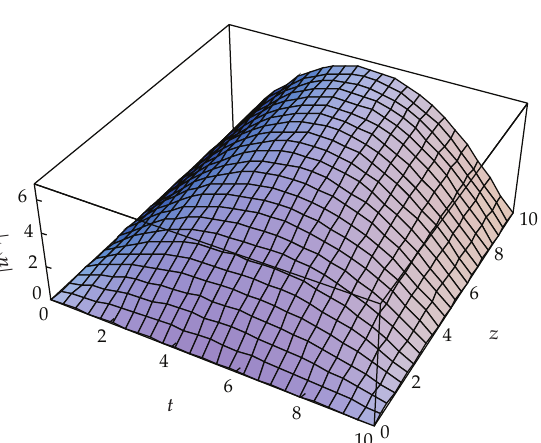
Figure 7: The zero-order approximation of | u (cid:3) 0 (cid:4) | at α (cid:8) 1, T (cid:8) 10, γ (cid:8) 02 with considering only one term in the series (cid:3) M (cid:8) 1 (cid:4) .